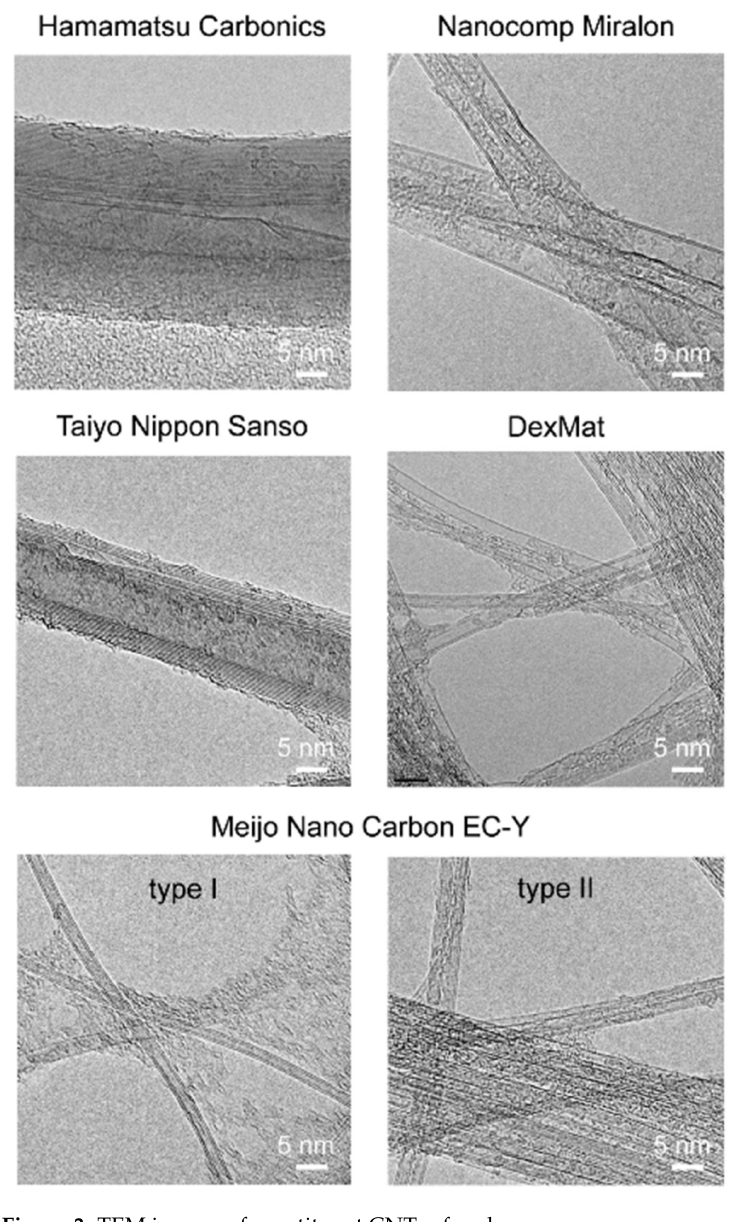
Figure 3. TEM images of constituent CNTs of each